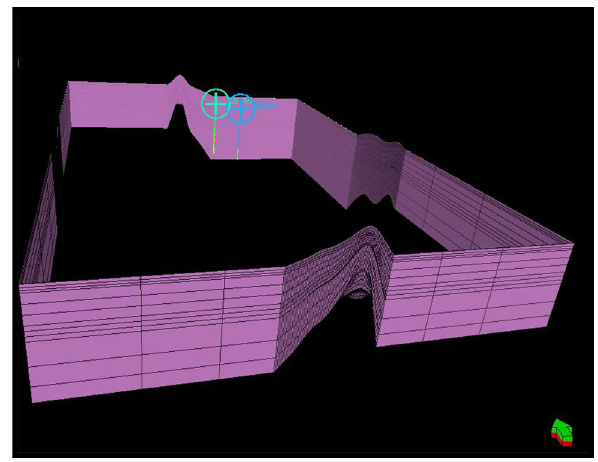
Fig. 14 Deformation example of geomechanical